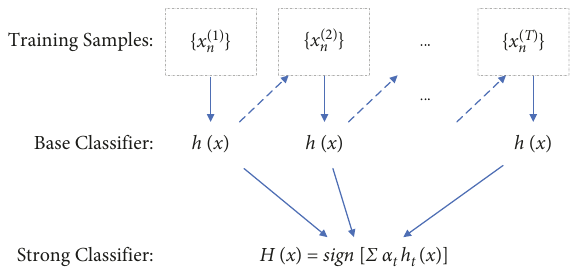
Figure 4: The base classifier training process of the AdaBoost